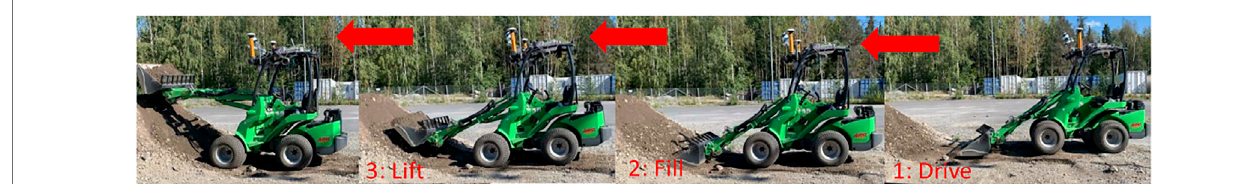
FIGURE 2 | Example of the typical stages in the pile loading task.